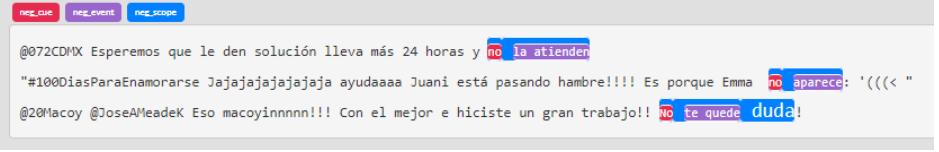
Figure 1. Example of tagged tweets with cue, event, and